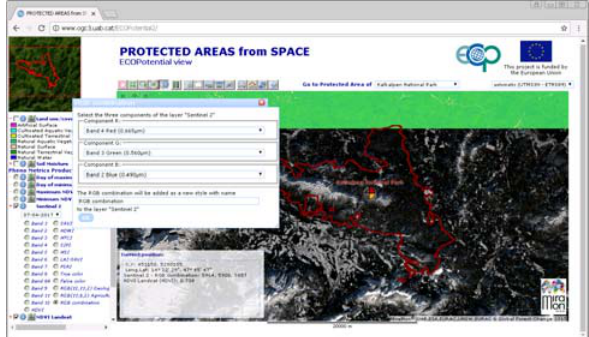
Figure 3. Screenshot showing an RGB on the fly combination from Sentinel-2 dataset for the Kalkalpen National Park for a particular date.